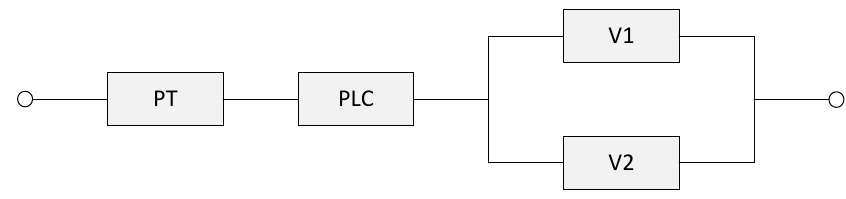
Figure 4. Reliability block diagram of the pressure vessel safety instrument system.